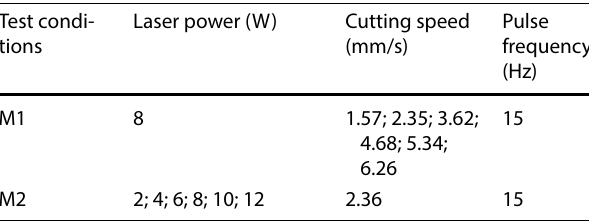
M1: Korean pine and Northeast China ash specimen of 3 mm machined under experimental conditions of different laser cutting speeds of 1.57 mm/s, 3.62 mm/s, 4.68 mm/s and 6.26 mm/s, pulse frequency of 15 Hz, at a constant laser power of the water-guided M2: Korean pine and Northeast China ash specimen of 3 mm machined under experimental conditions of different laser power of 2, 4, 6, 8, 10 and 12 W, pulse frequency of 15 Hz, at a constant laser cutting speed of the water-guided laser system of